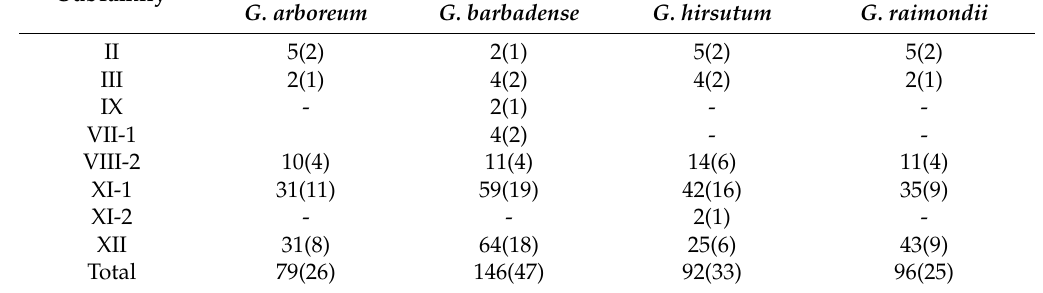
Table 2. Number of identified tandem duplicated LRR-RLK genes among different subfamilies in four Gossypium species. Number of tandem duplicated gene sets in each subfamily were indicated in brackets. Number of Tandem Duplicated Genes (Gene Sets) Subfamily